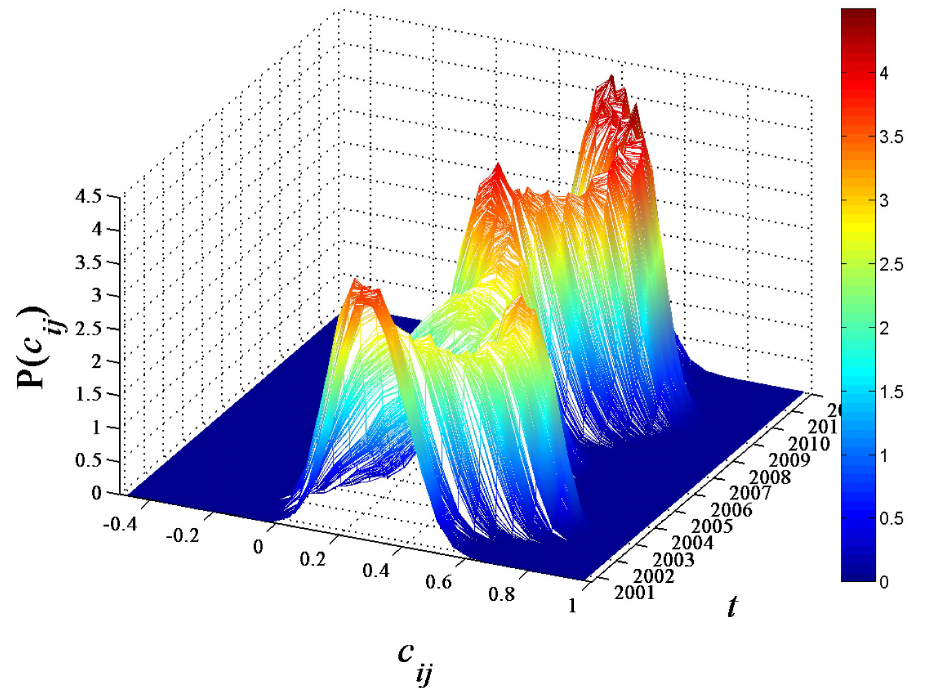
Figure 1. Dynamics of correlation coefficient distribution. Probability density function (PDF) P ( c ij ) of the correlation coefficients calculated from the return series of 367 A-Share stocks evolved with the time t .